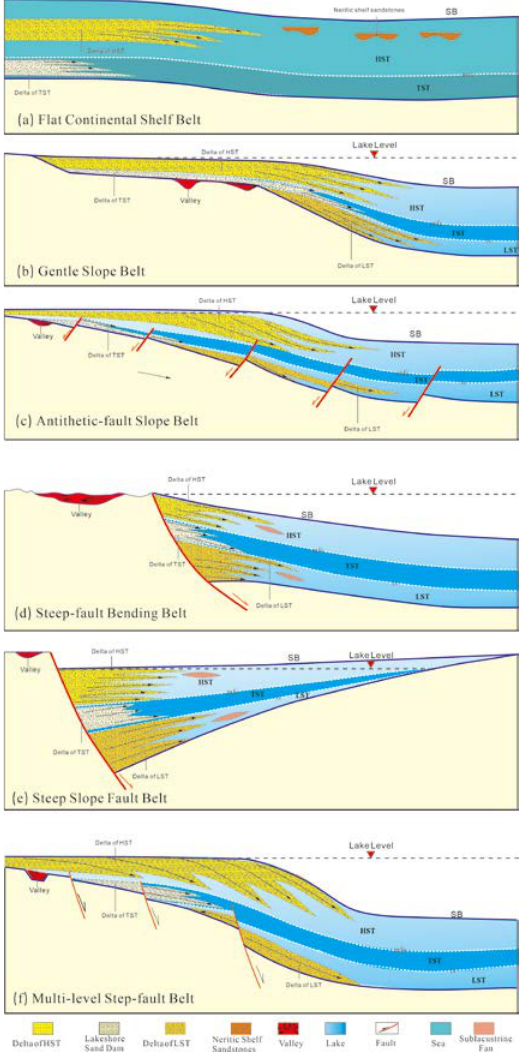
Figure 10. The types of slope break belts and their stratal stacking patterns in the Zhu III Depression,